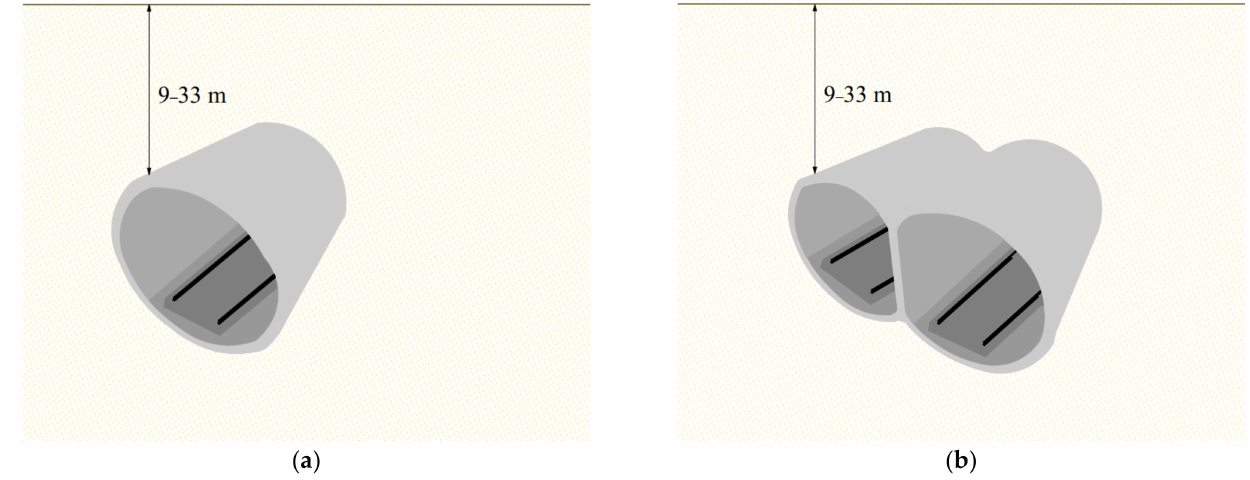
Figure 4. Type of tunnel often adopted in Shanghai. ( a ) Circular tunnel; ( b ) double-tube tunnel